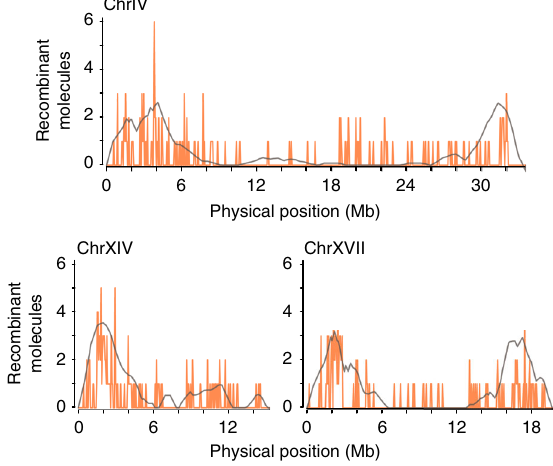
Fig. 3 ReMIX recombination maps of example autosomes in a male freshwater stickleback. ReMIX analysis of linked-read data is plotted as the number of crossovers in 50 kb windows (orange). For comparison, recombination rate estimates obtained from a F2 lab cross 31 of 140 males and 142 females individuals genotyped at 1872 markers are shown as gray